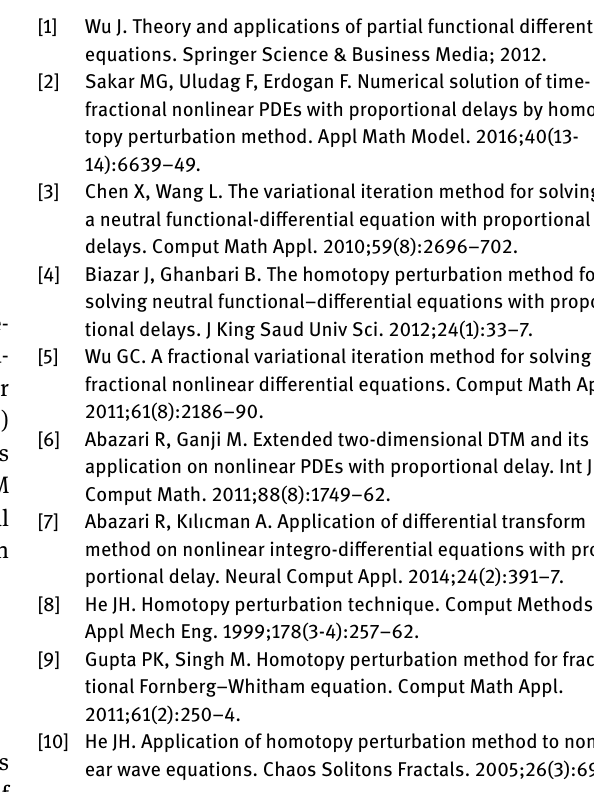
− 1 = 12 − 1 = 11 and k = 2.201. The cal- tab . | ; DTM with exact so- i , i = 1, 2, 3 are i